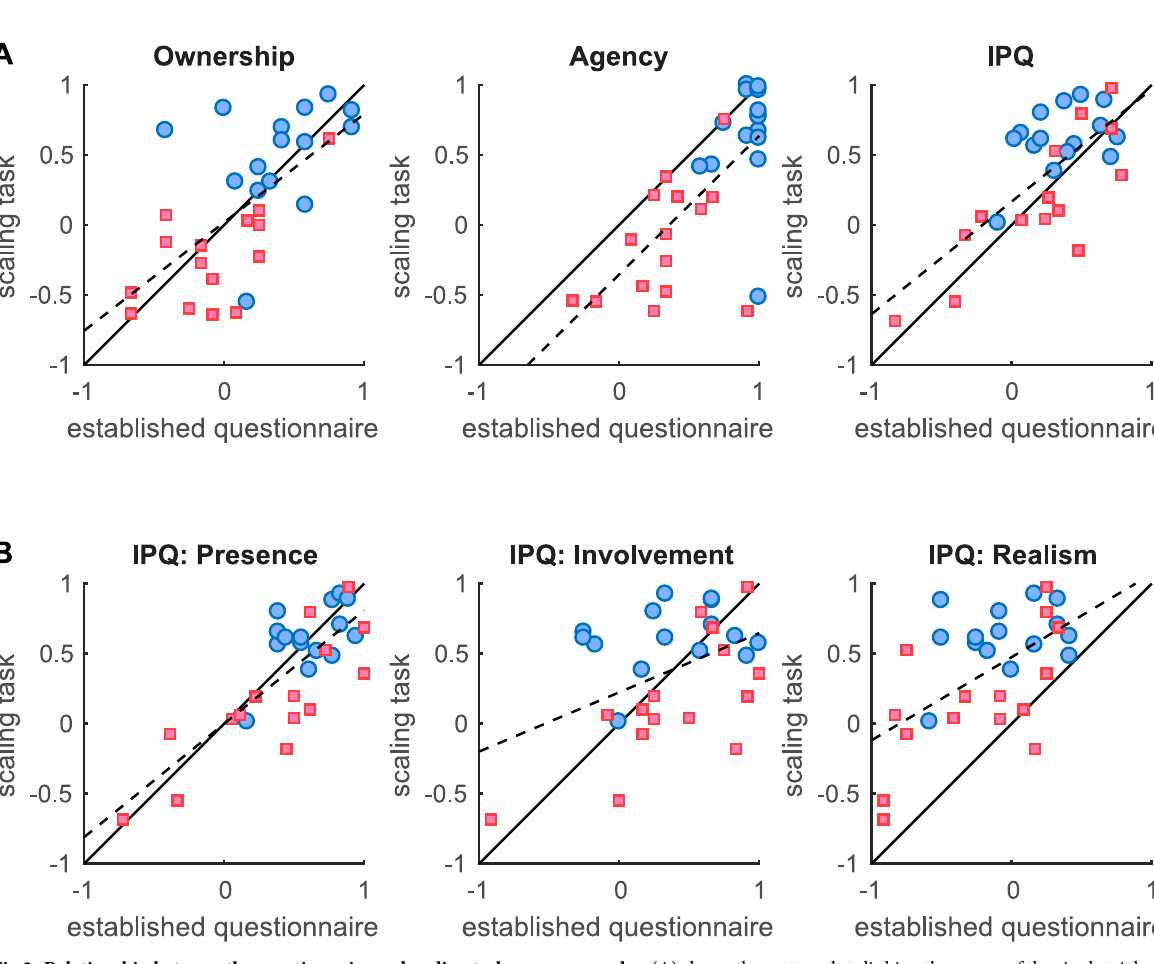
Fig 3. Relationship between the questionnaire and scaling task response modes. (A) shows the scatter plots linking the scores of the single trial sliding scales to the scores of the established ownership and agency as well as the IPQ questionnaires. The scatter plots in (B) shows the correspondence between each of the IPQ sub-scales and the presence ratings using the scaling task within VR. The average scores obtained using the established questionnaires were divided by 3 to obtain a scale ranging from -1 to +1 as in the scaling task for each trial. Each point in the plot represents an individual participant and for each participant there is a point both for the No Delay (blue disks) and the Delay (red squares) conditions. The continuous black line represents the prediction of both types of scores (sliding scales and established questionnaires) being equal. The dashed black line represents the best linear fit using linear